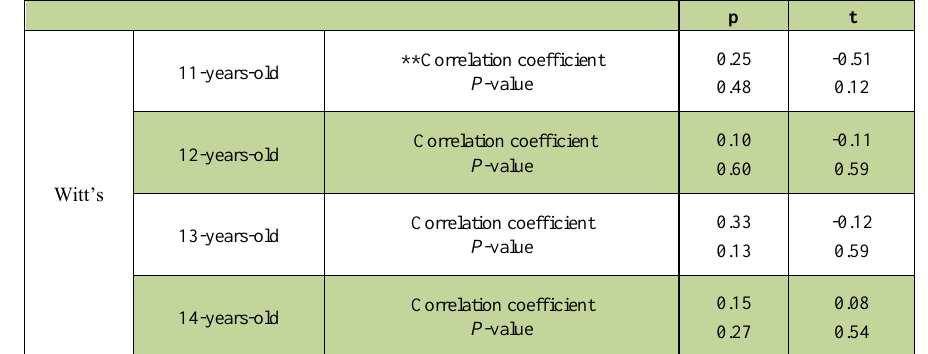
Table 3. Relationships between the values of Witt’s, ANB, p, and t indices by different age